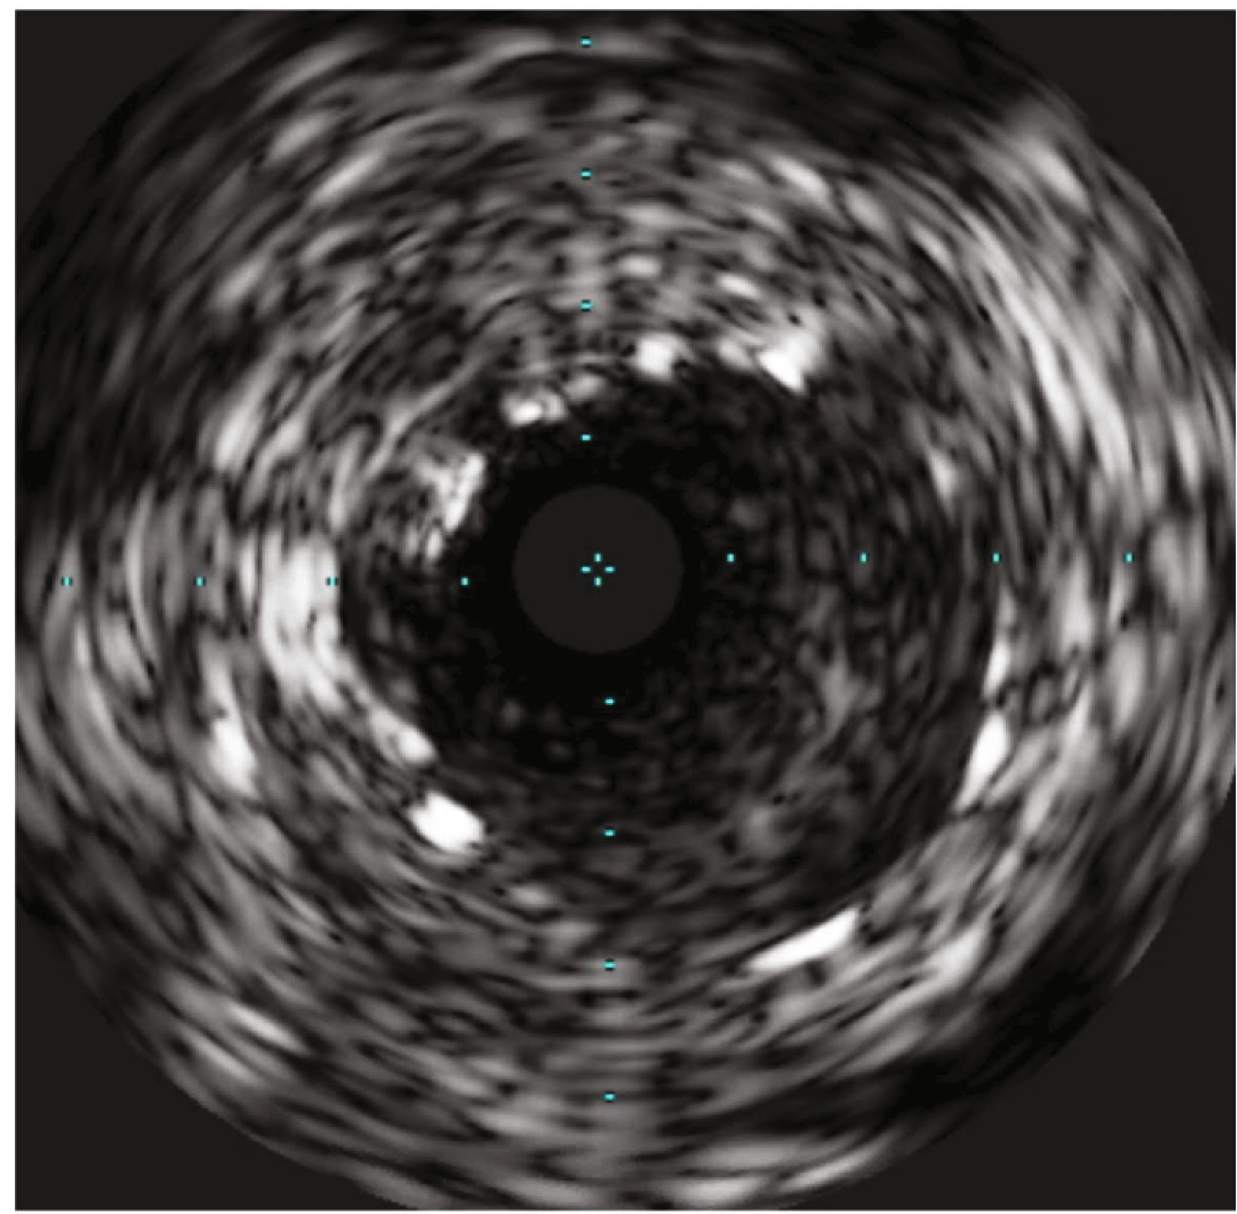
Figure 11: The patient has IVUS view of severe instent restenosis after anjiojet